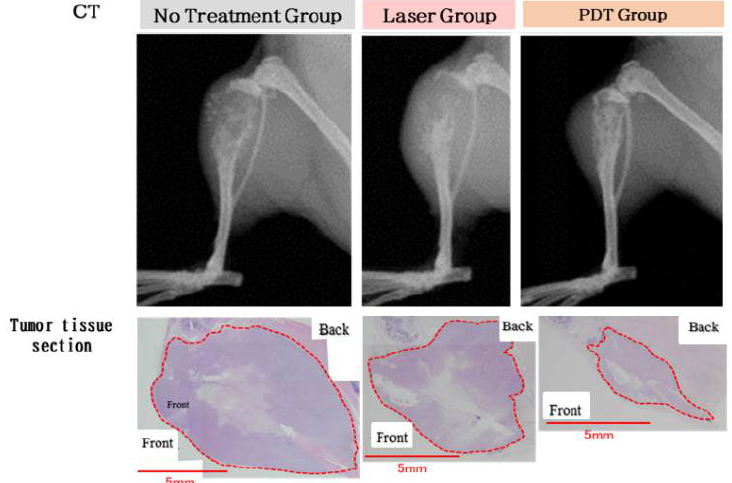
Figure 5. Photodynamic therapy (PDT) in bone metastases. The photodynamic therapy group underwent laser irradiation 24 h after ICG-lactosome administration at 1, 3, and 5 weeks after tumor cell transplantation. The area of osteolysis was compared using computed tomography imaging at 7 weeks after tumor cell transplantation. The area surrounded by the dotted line indicates tumor cells. The PDT group showed smaller tumor areas than the laser group. (Reproduced from Ozeki and Hara